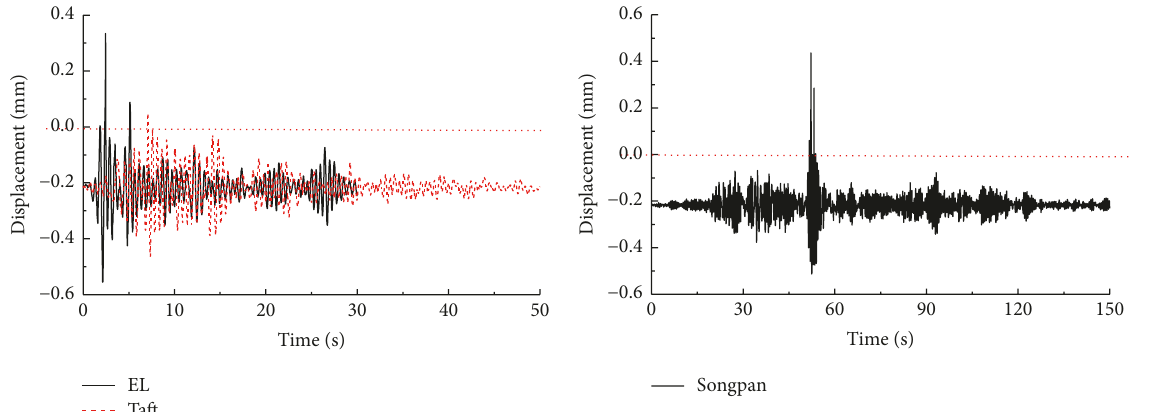
Figure 22: Comparison of vertical displacement time history curves at node 1 under EL, Taft, and Songpan waves.